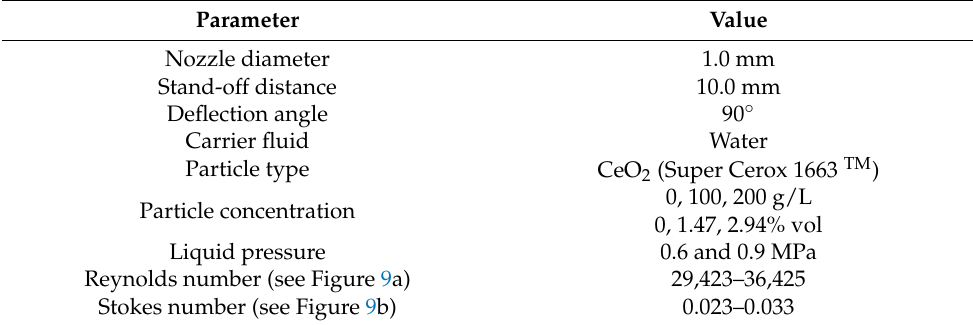
Table 2. Operating conditions adopted in the numerical setup.